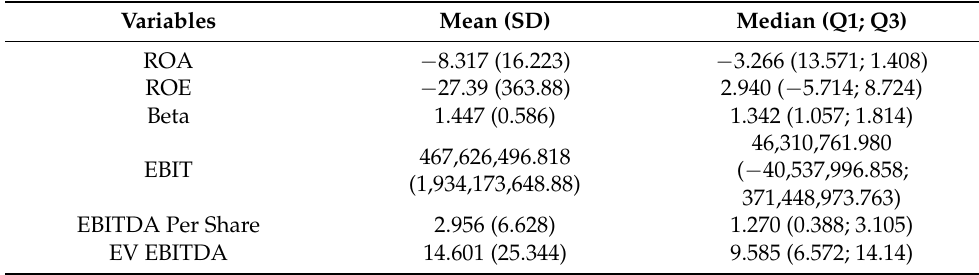
Table 2. Descriptive statistics of the sample firms.